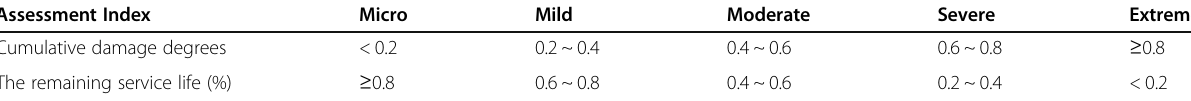
Table 7 Assessment standard of pavement fatigue damage based on the miner criterion